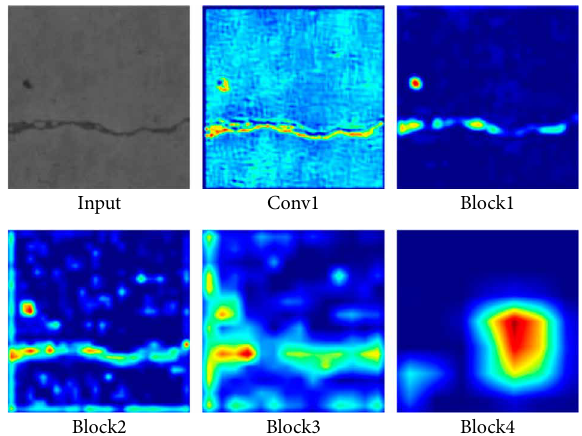
Figure 4: Visualization results of crack feature maps at different levels, in which the feature resolution of the shallow network is higher, retaining the crack characteristic details. The deep features are more abstract and have strong discriminant